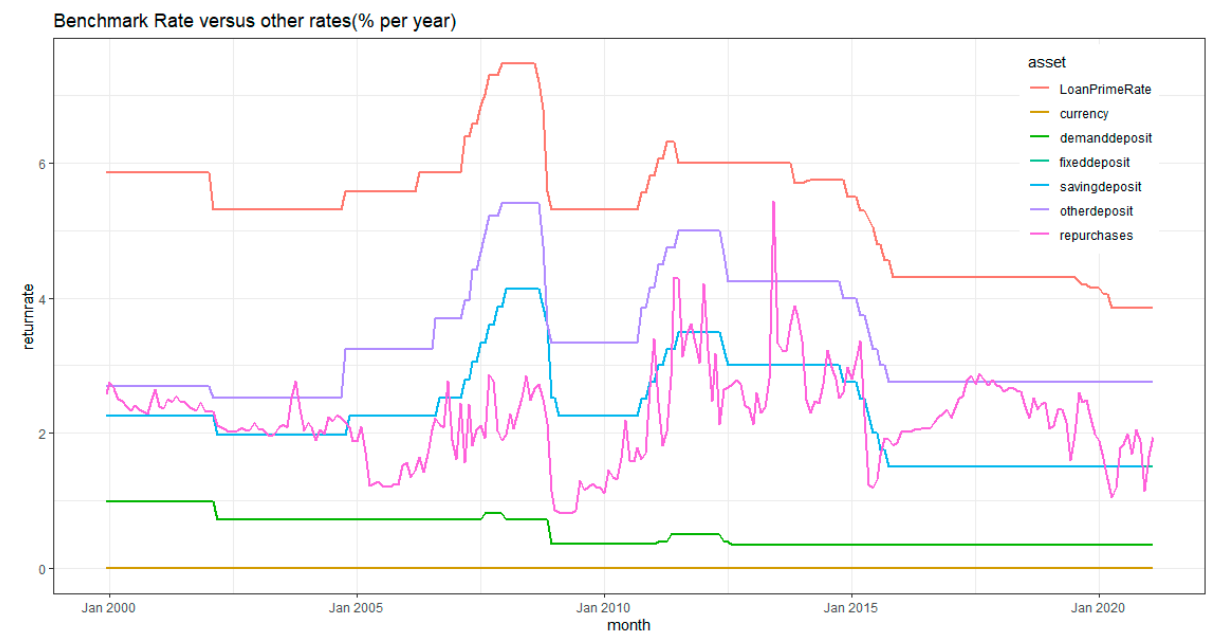
Figure 5. Benchmark rate and other return rates in long time horizon (2000–2020).